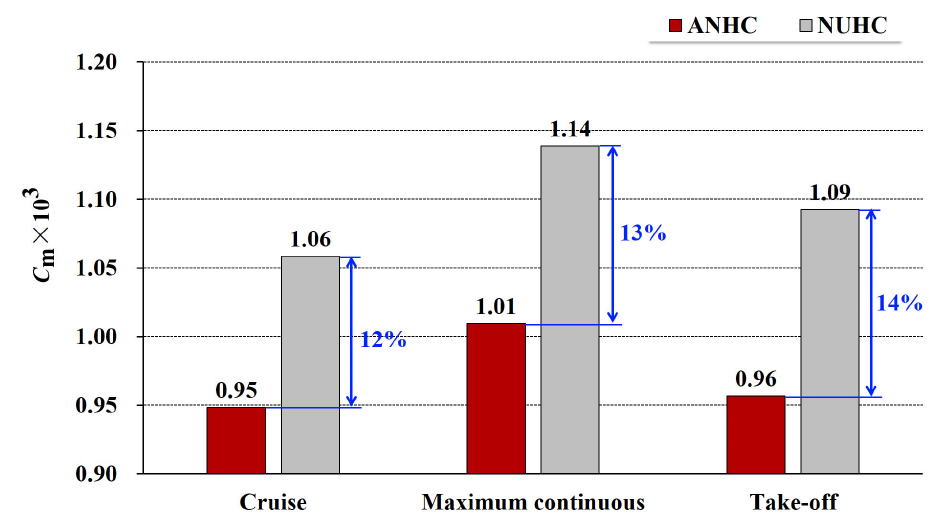
Figure 25. Moment coefficient of rotating disk surface under ANHC and NUHC.